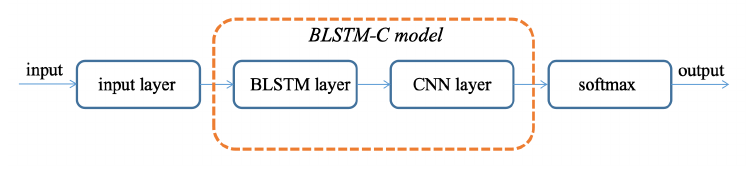
Figure 1. Classification